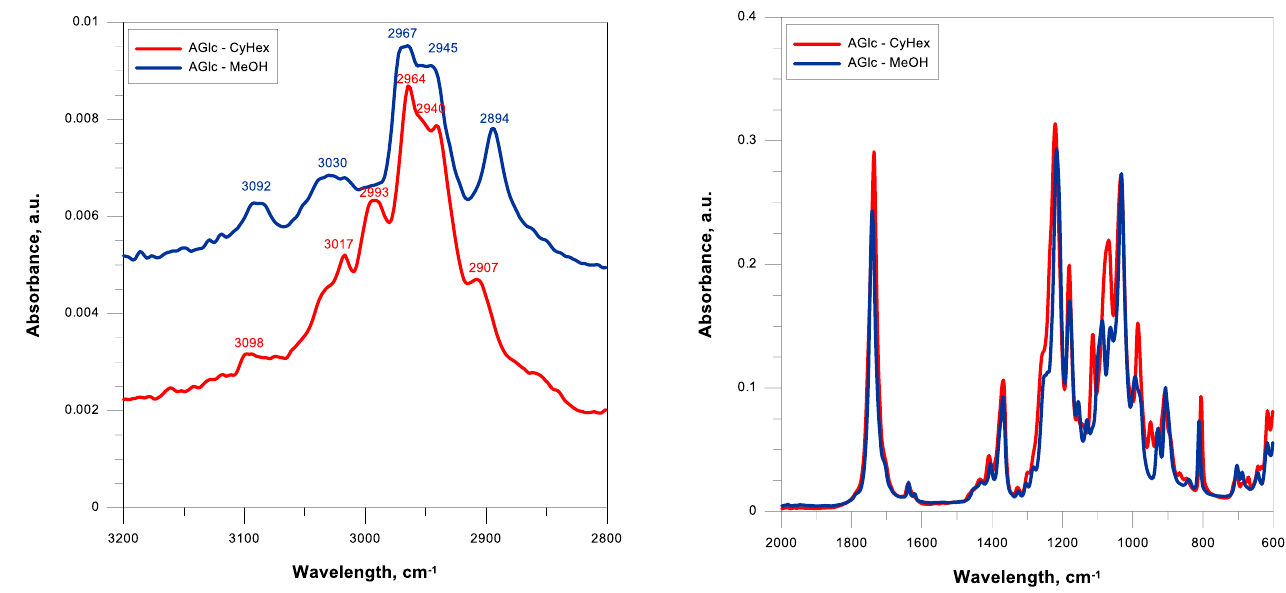
Figure 9. FTIR spectra of MGlc monomer crystallised from methanol (blue line), and cyclohexane (red line).